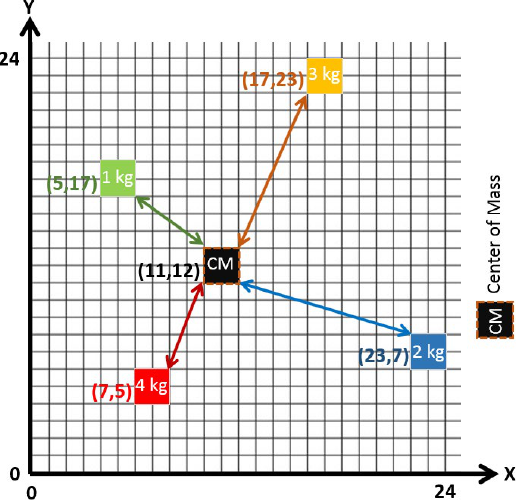
Figure 2. Center of mass of four points with different masses in a two-dimensional (2D) space.